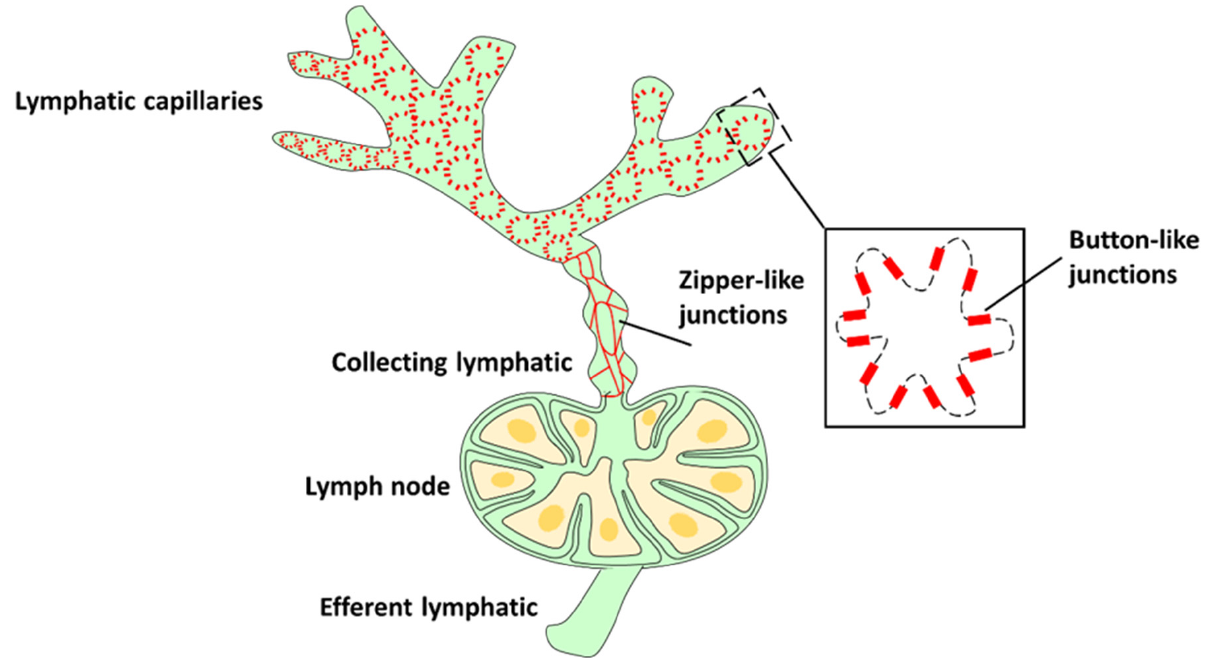
Figure 2. Organization of the lymphatic network. Afferent lymphatics start as blind-ended capillaries in peripheral tissues [32] . These then branch and merge with collecting vessels, which feed into a draining lymph node [33] . The endothelium of collecting vessels has continuous zippers that prevent vascular leaks and allow transport of the lymph. Lymph fluid and leukocytes leave the lymph node through the efferent collecting vessels.